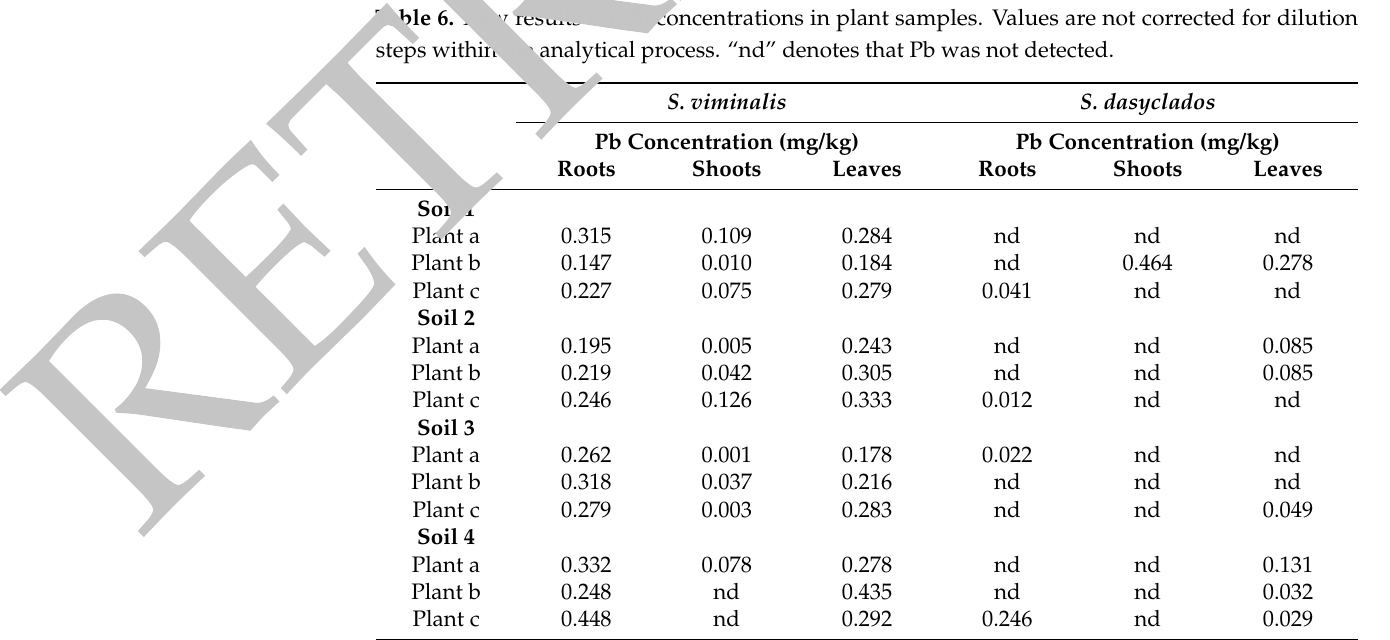
Table 6. Raw results for Pb concentrations in plant samples. Values are not corrected for dilution steps within the analytical process. “nd” denotes that Pb was not